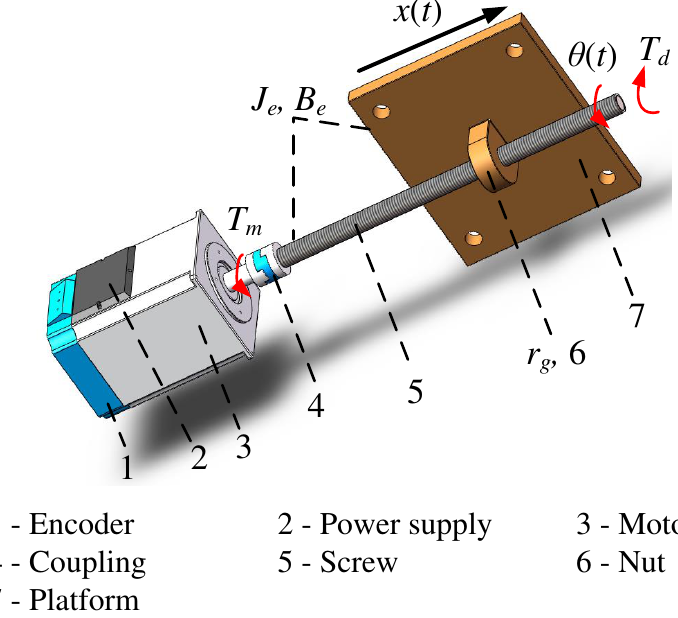
Figure 1. Servo system reference